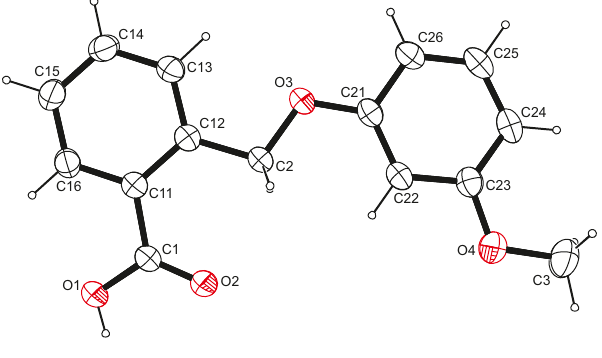
Table  : Data collection and